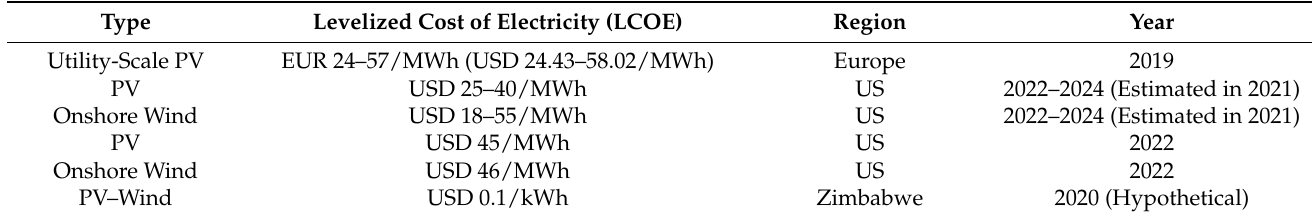
Table 1. Levelized cost of PV and wind systems compared